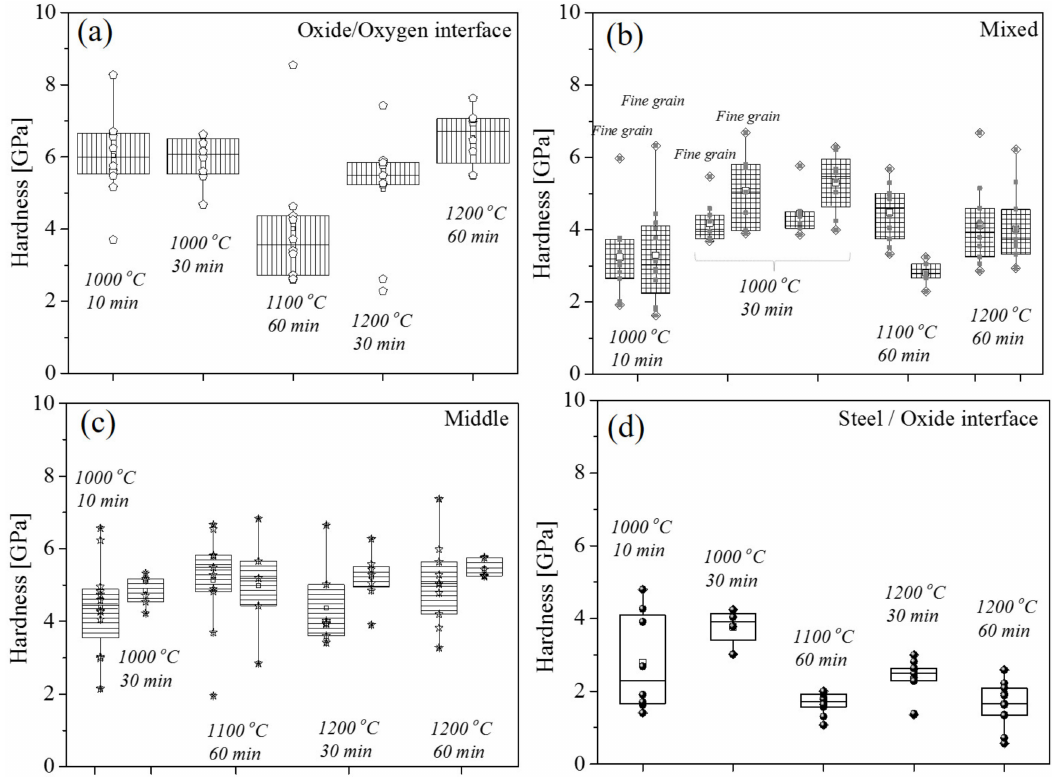
Figure 12. Hardness values of phases formed at the ( a ) oxide / oxygen, ( b ) mixed, ( c ) middle, and ( d ) steel / oxide